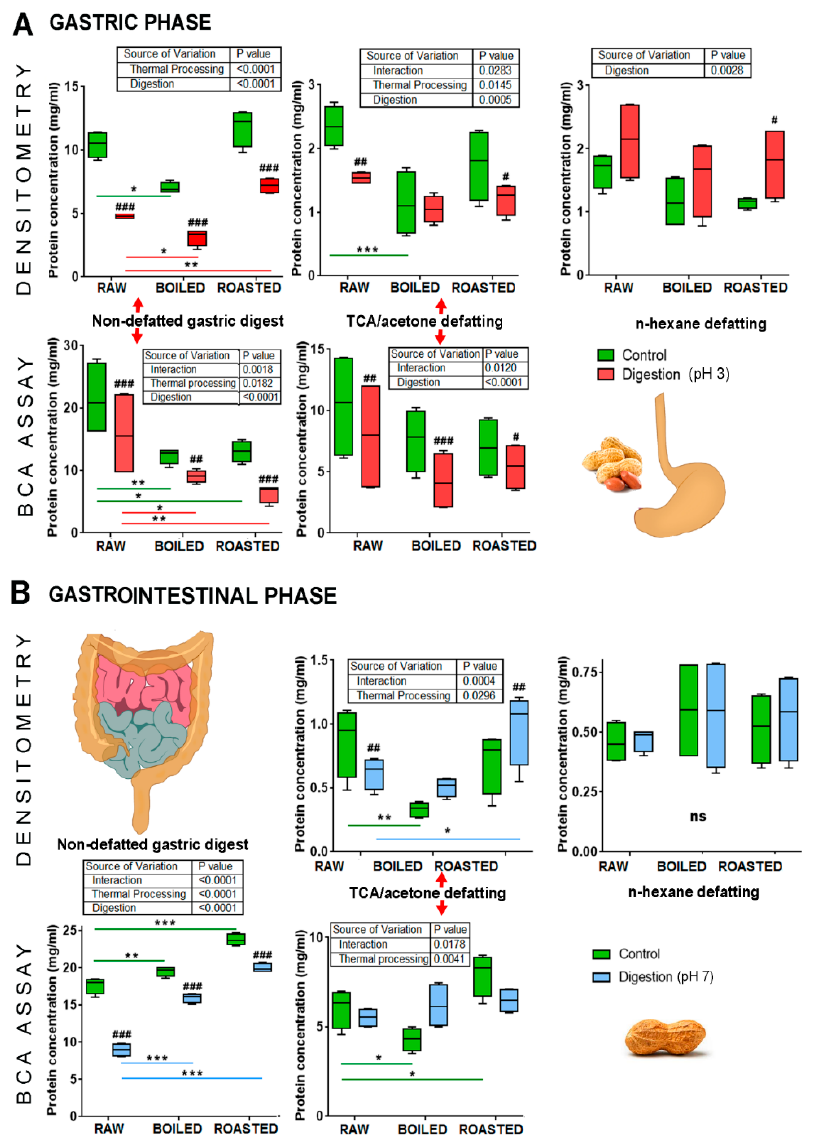
Figure 1. Protein concentrations in the full liquid phases of the control (extraction), gastric and gastrointestinal digested raw, boiled, and defatted peanuts and following n-hexane and TCA/acetone defatting. A —Gastric phase—protein content determined by densitometry and BCA assay, before and after defatting with n-hexane and TCA precipitation. B —Intestinal phase—protein content determined by densitometry and BCA assay, before and after defatting with n-hexane and TCA precipitation. A two-way ANOVA with matched measurements was employed on at least two independently performed digestions (followed by defatting treatment, if done). Both BCA assay and ImageQuant TL densitometry included technical duplicates. Multiple comparison testing was done following two-way ANOVA with repeated (matched) measures via Sidak’s and Dunnett’s post-tests to test differences in digestion within a single thermal treatment and across thermal treatments, respectively; ns—not significant (e.g., p > 0.05): #, ##, and ###—significantly different digested sample from its control at p < 0.05, p < 0.005, and p < 0.0001, respectively. *, **, and ***—significantly different boiled or roasted peanut sample compared to a raw peanut sample at p < 0.05, p < 0.005, and p < 0.0001, respectively.